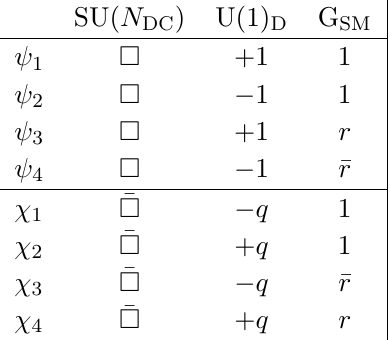
= SU(3) SU(2) U(1) with r = ( 3 , 1 ) , SM c × EW × Y + y